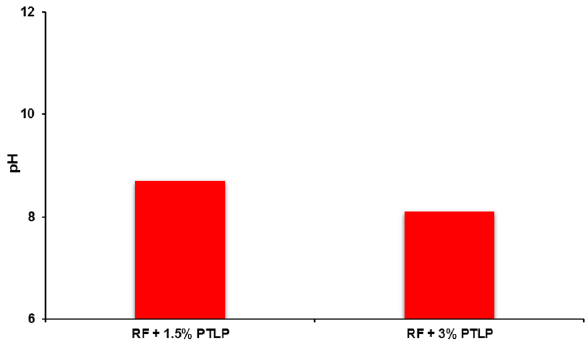
Fig. 8 The influence of PTLP on pH (aged